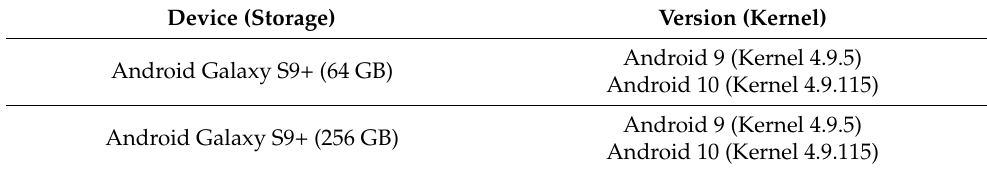
Table 6. Android device used in